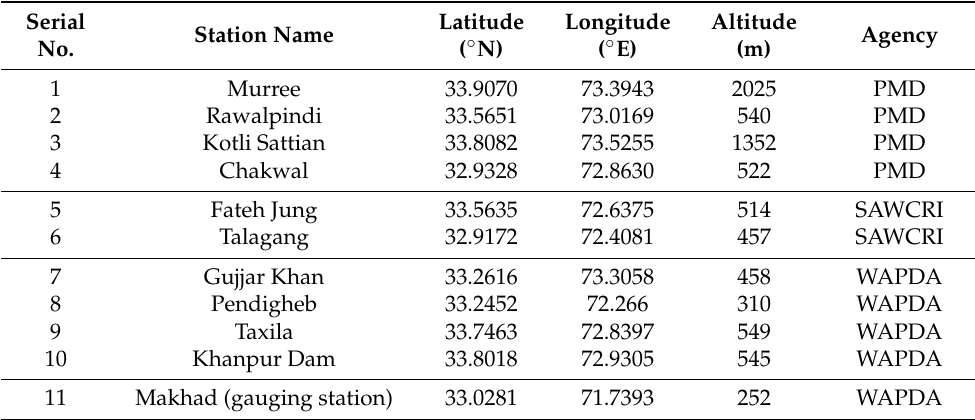
Table 2. Attributes of rain gauge and discharge